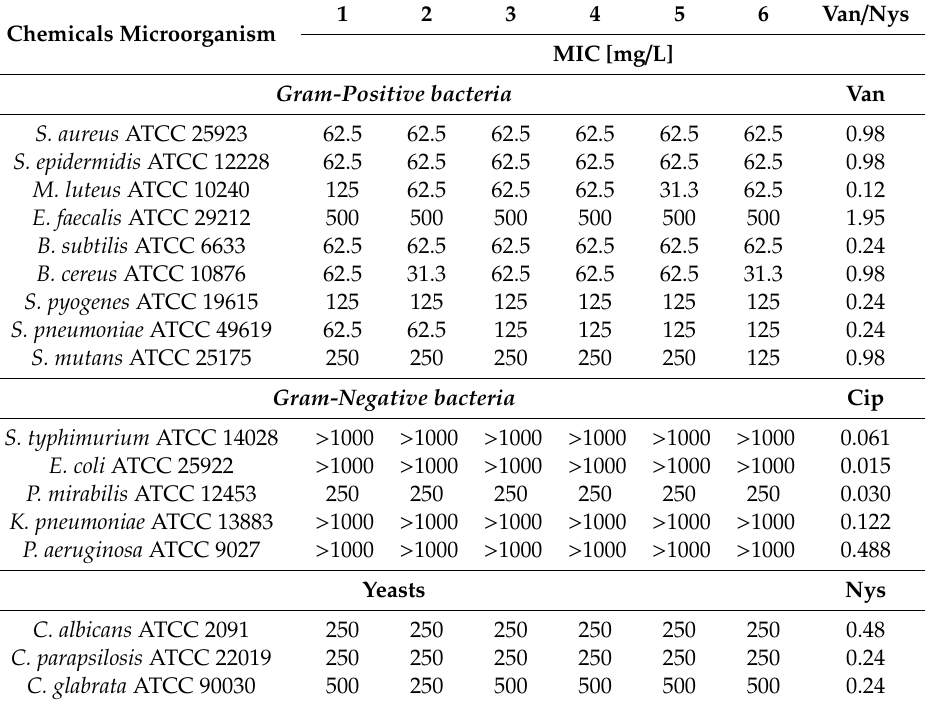
Table 4. The antibacterial and antifungal